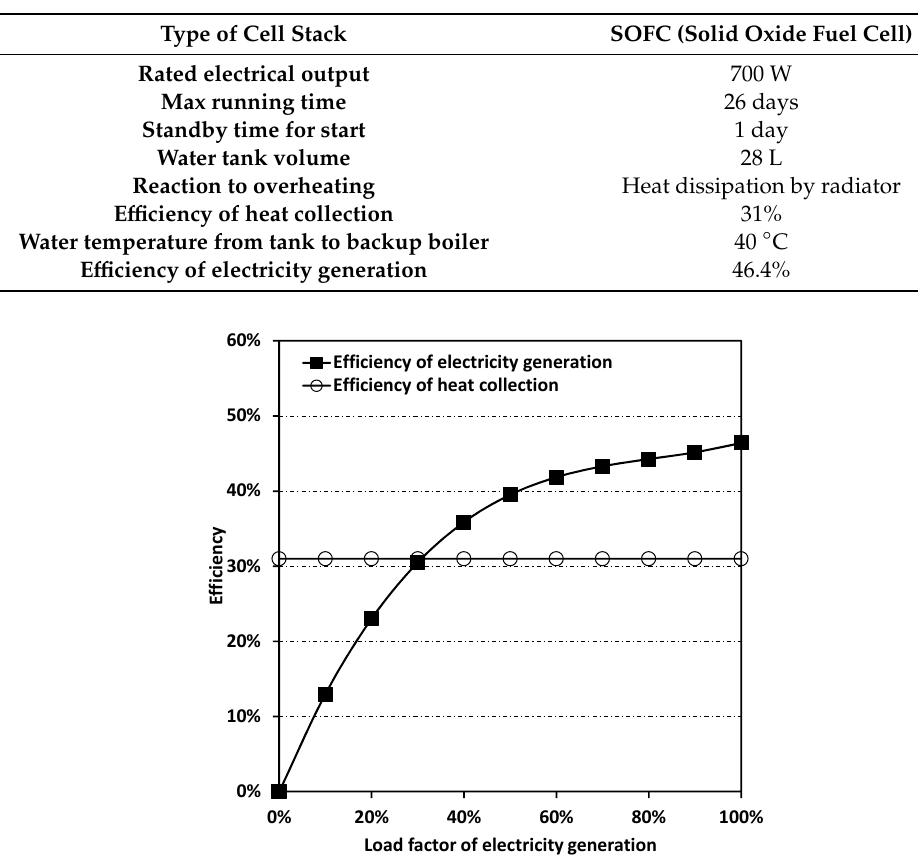
Figure 4. Working principle of the solid oxide fuel cell cogeneration system (SOFC–CGS). Table 6. Specifications of the SOFC–CGS.